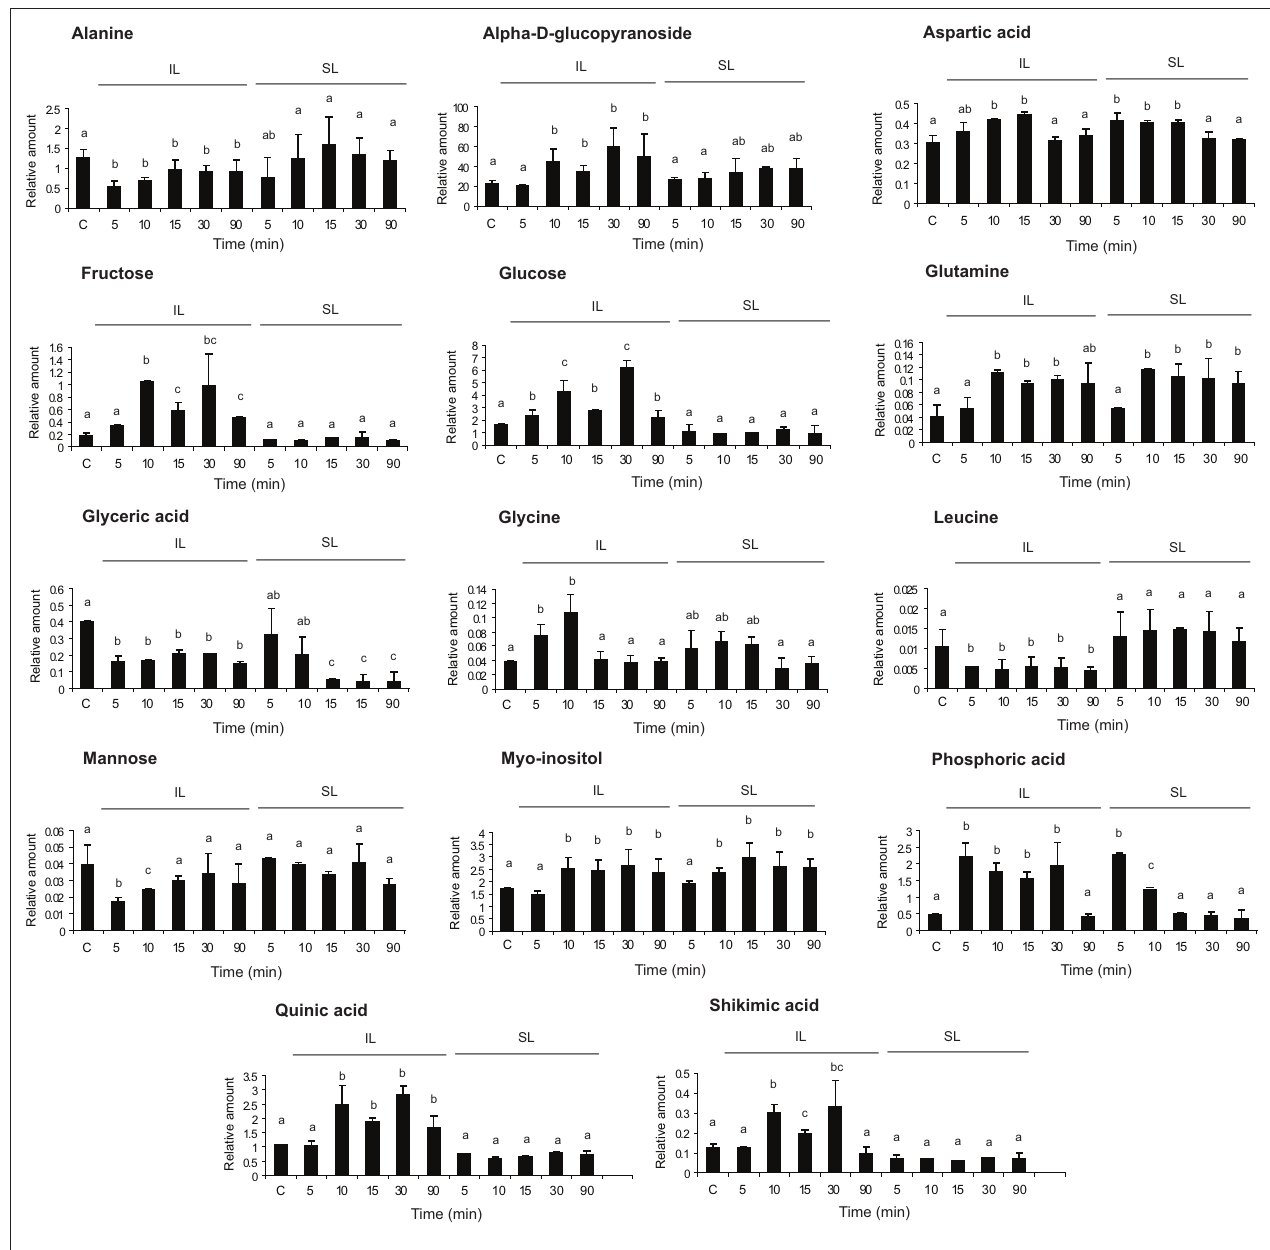
FigURe 4 | Metabolic profiling from UV-B-irradiated leaves. Metabolites from maize leaves from irradiated (IL) and shielded (SL) leaves from maize plants that were covered with a plastic sheath that absorbs UV-B, and only two adult leaves per plant were irradiated with UV-B radiation during 5, 10,